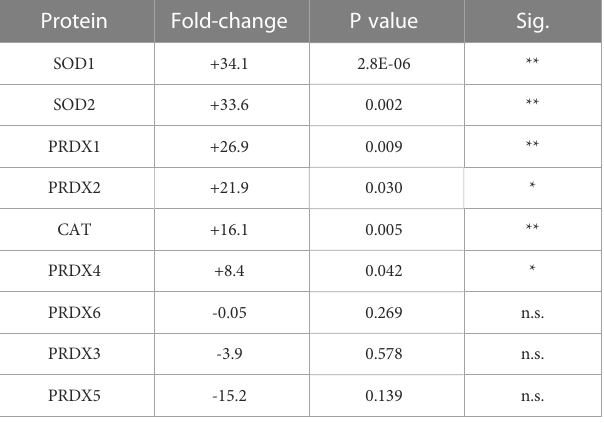
TABLE 2 Effect of tBHP on Peroxidase and SOD Expression. Protein Fold-change P value